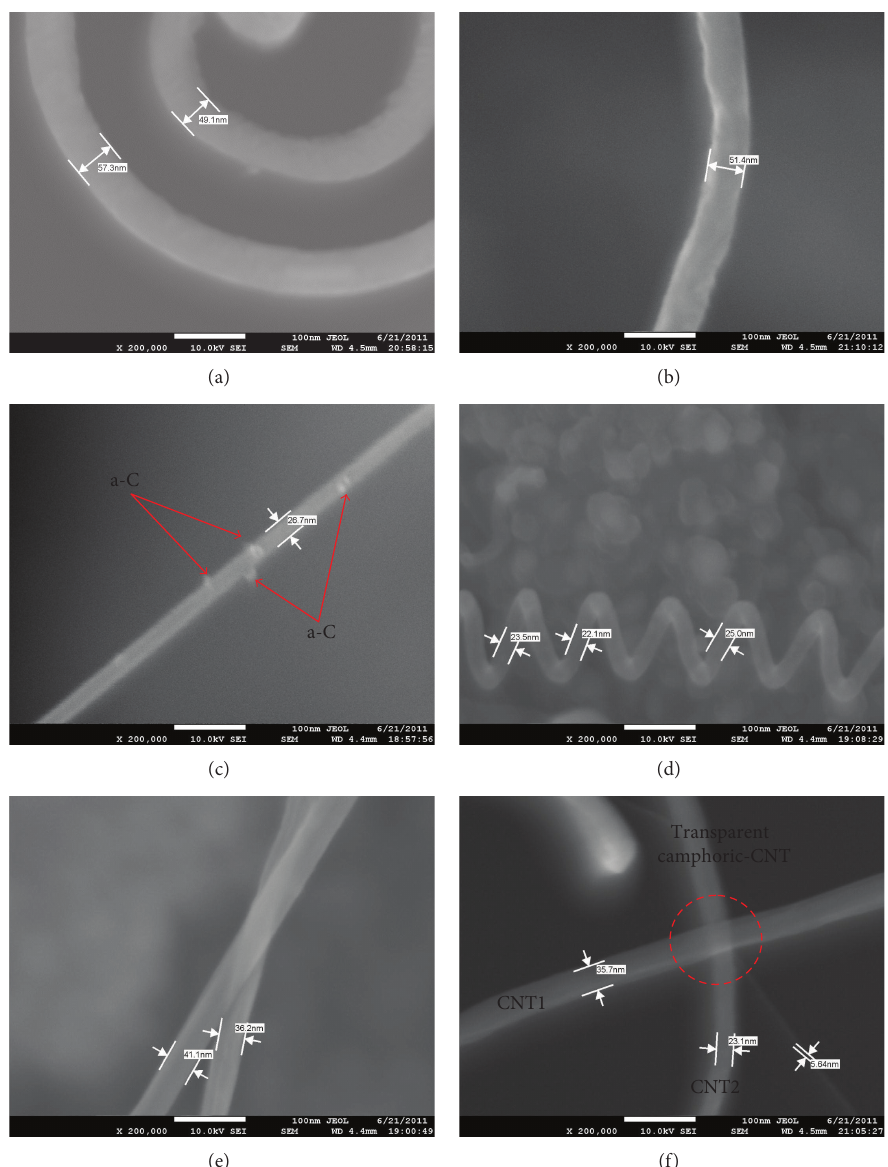
(f) C thermal annealing ∘